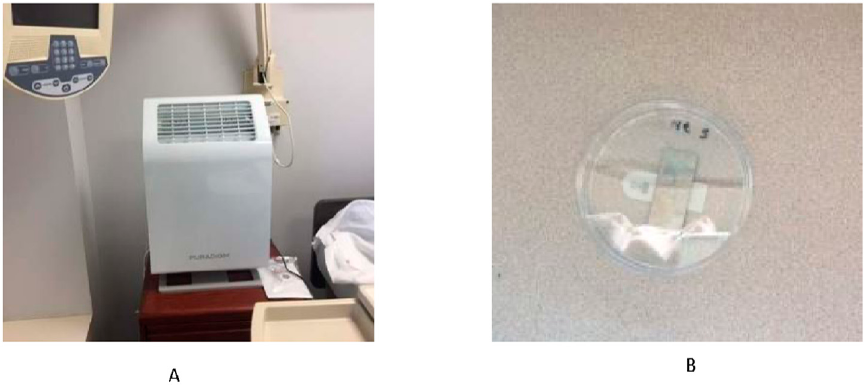
Figure 1. The photocatalytic reactor setup in the hospital room. ( A ) The photocatalytic reactor. ( B ) Sterile stainless steel carriers were individually placed in sterile petri dishes and affixed to the bottom of each petri dish with adhesive and placed at multiple locations .